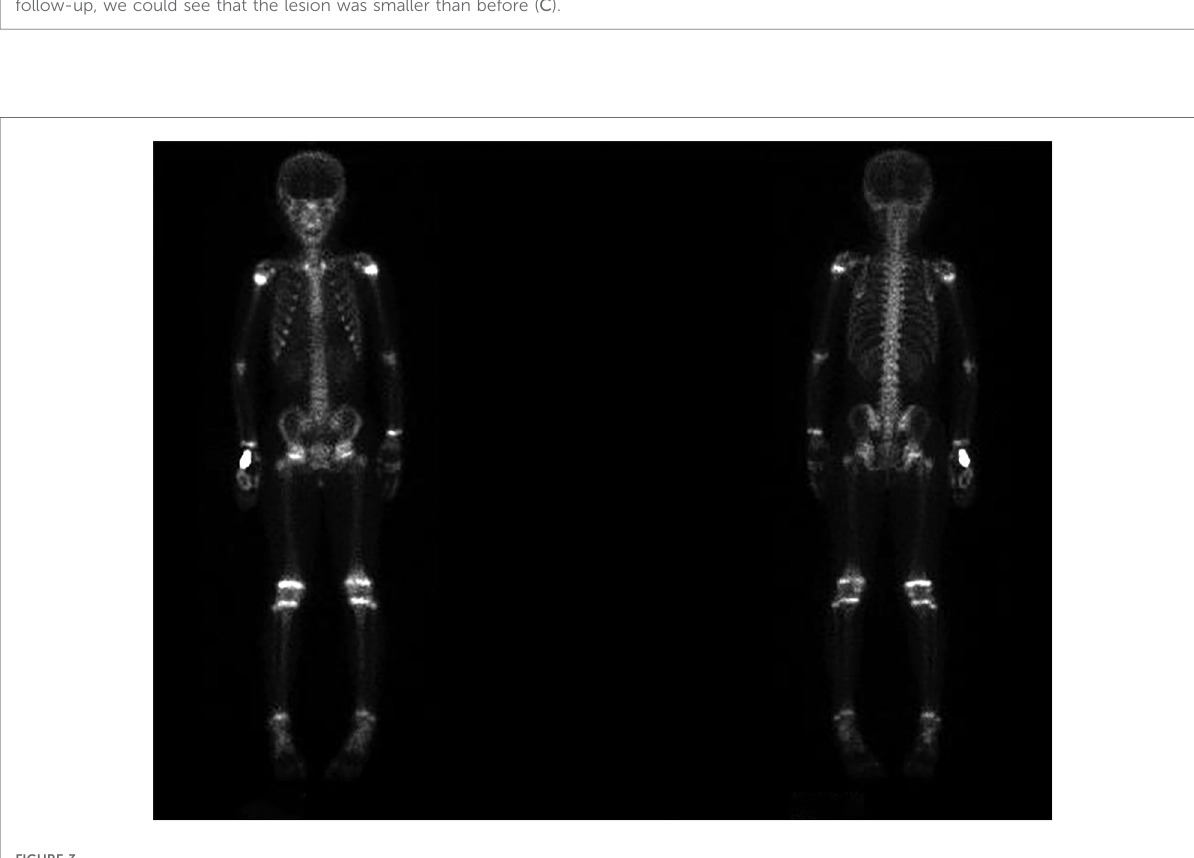
FIGURE 3 Whole-body bone imaging showed increased radiation in bone metabolism of bilateral lower femurs after intravenous 10 mCi of 99 mTc-MDP.